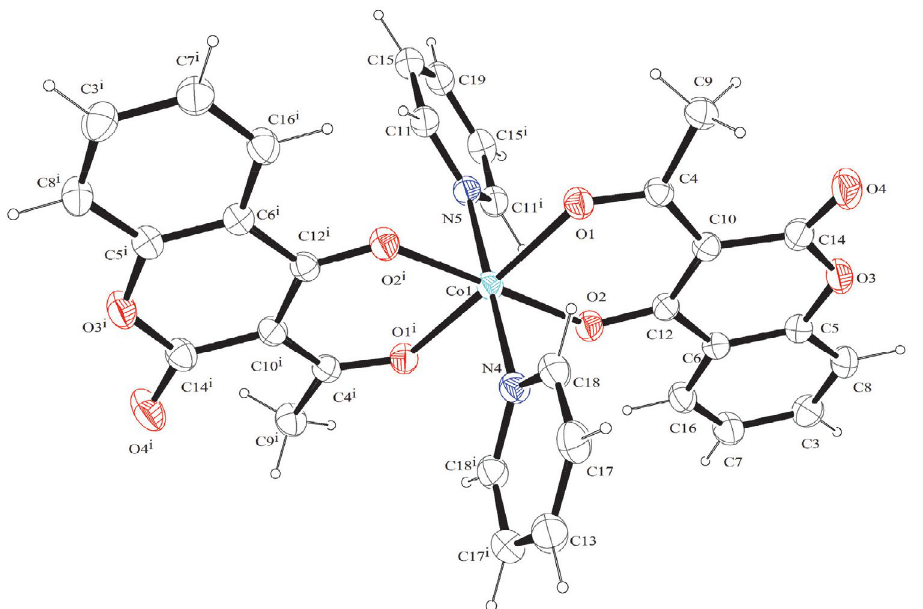
Figure 5. A perspective view of complex showing the atom-labelling scheme and displacement ellipsoids at the 50% probability level, symmetry code: (i) – x , y , ½ – z